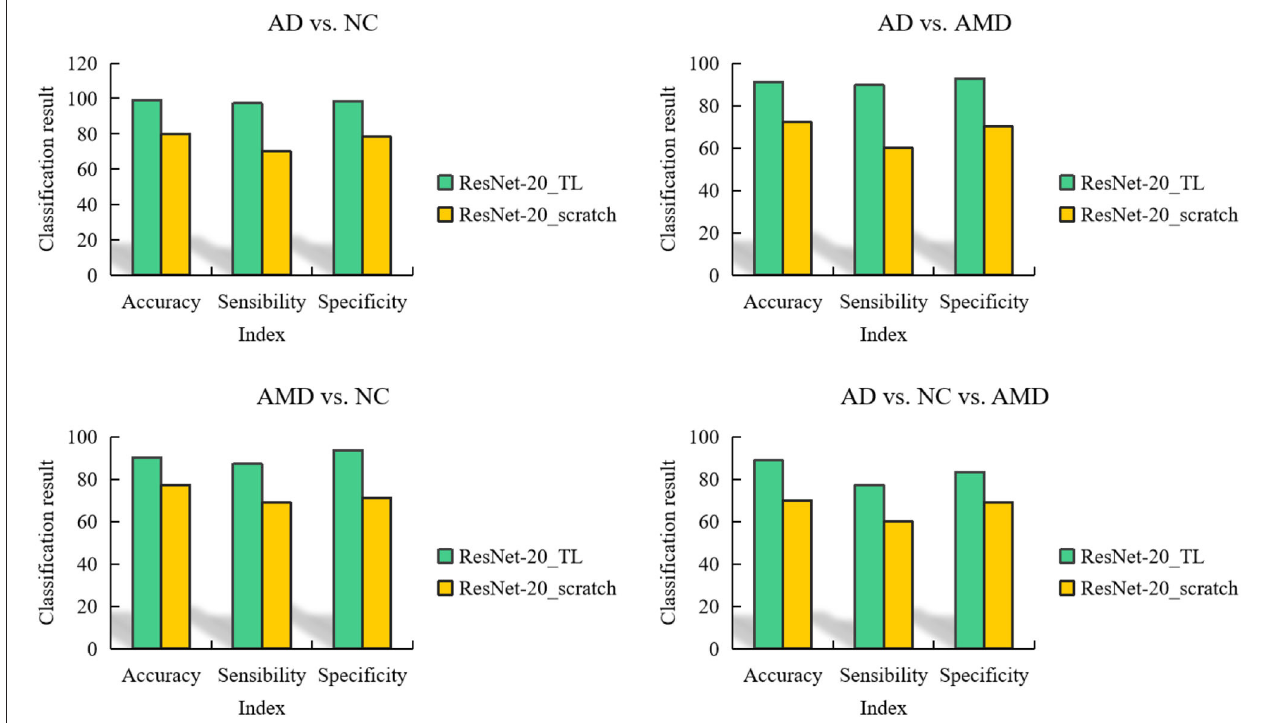
FIGURE 8 | Comparison of classification results obtained by 2 ANN models in 4 classification tasks.